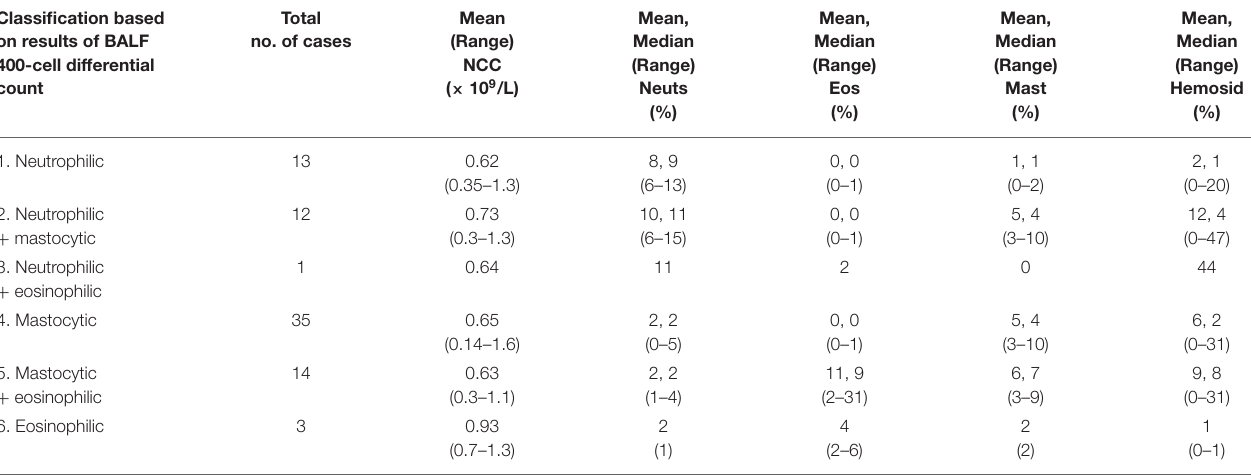
TABLE 2 | Classification of inflammatory cell types from 78 horses with an increased proportion of lower airway granulocytes. Classification based on results of BALF 400-cell differential